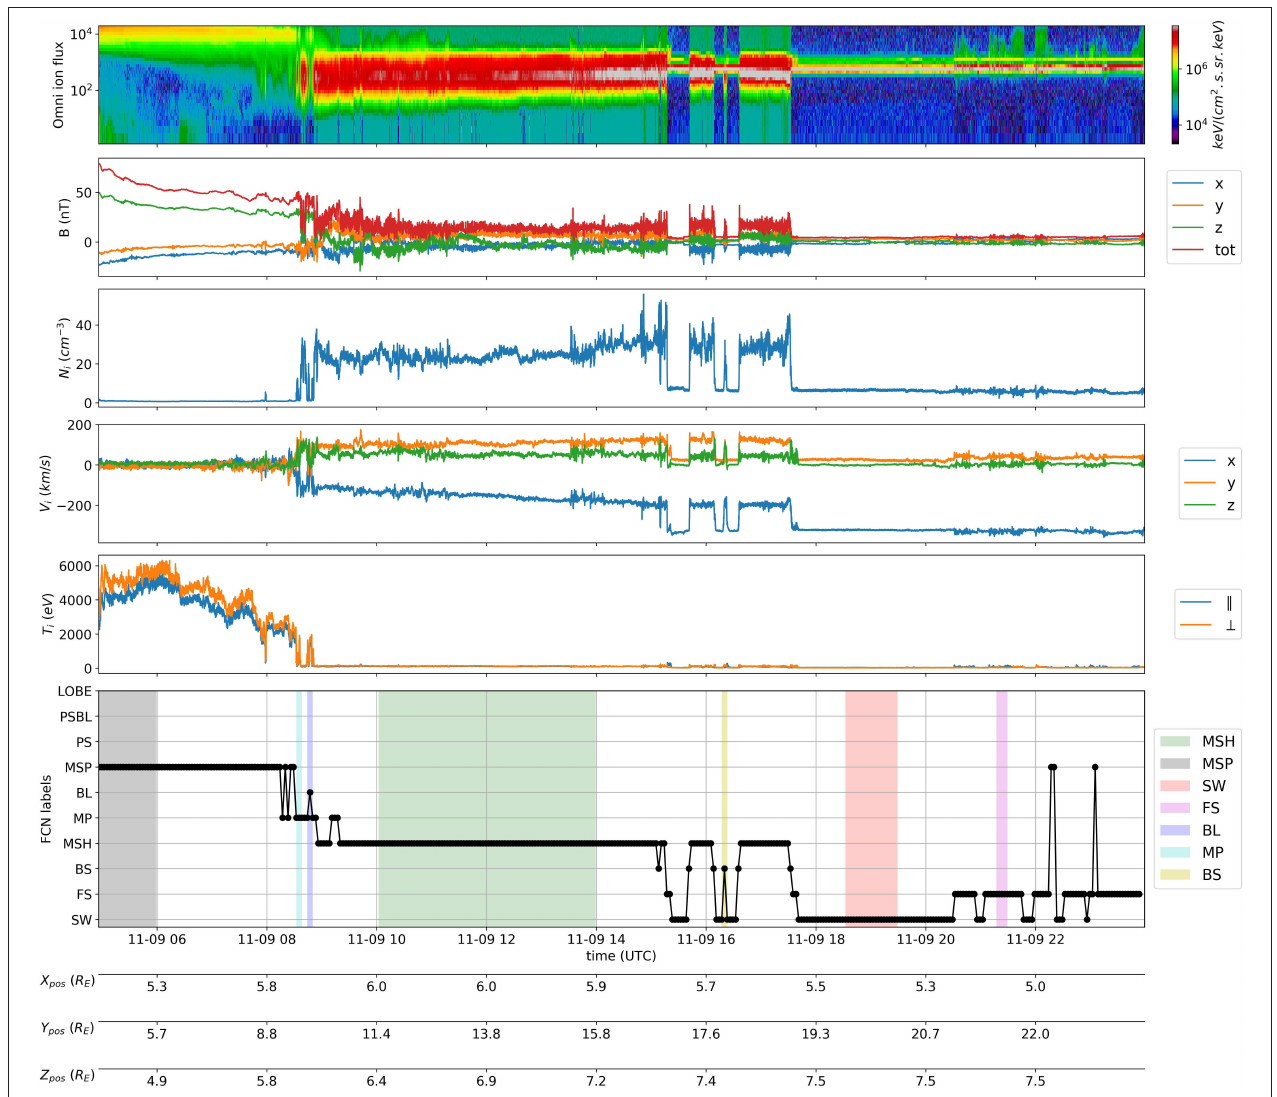
FIGURE 3 | Example of MMS dayside classification. Labels, not present in the initial data set, have been manually added to compare the FCN predictions with a ground truth. They are represented by colored regions on the FCN labels plot. intervals are involved in the decision of the classifier for